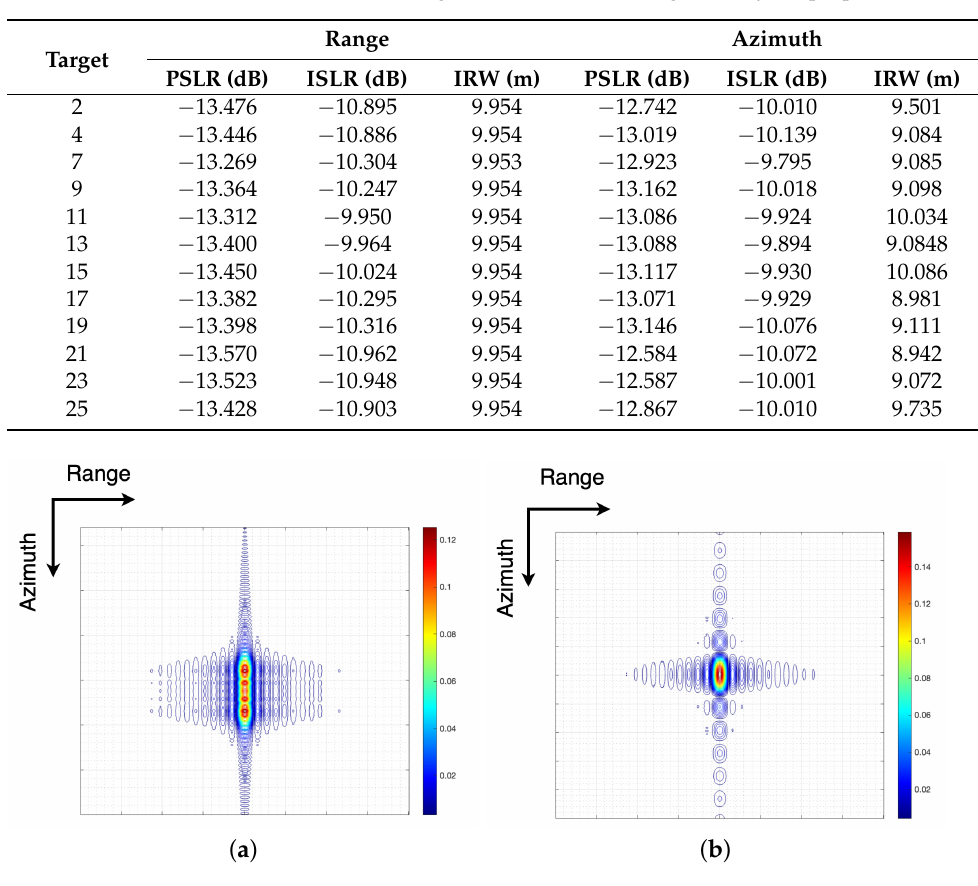
Table 4. PSLR, ISLR, and IRW of selected targets of TOPS mode in Figure 13 by the proposed method.